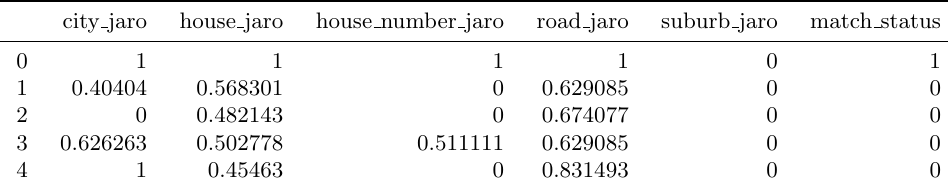
Table 3: Output of code